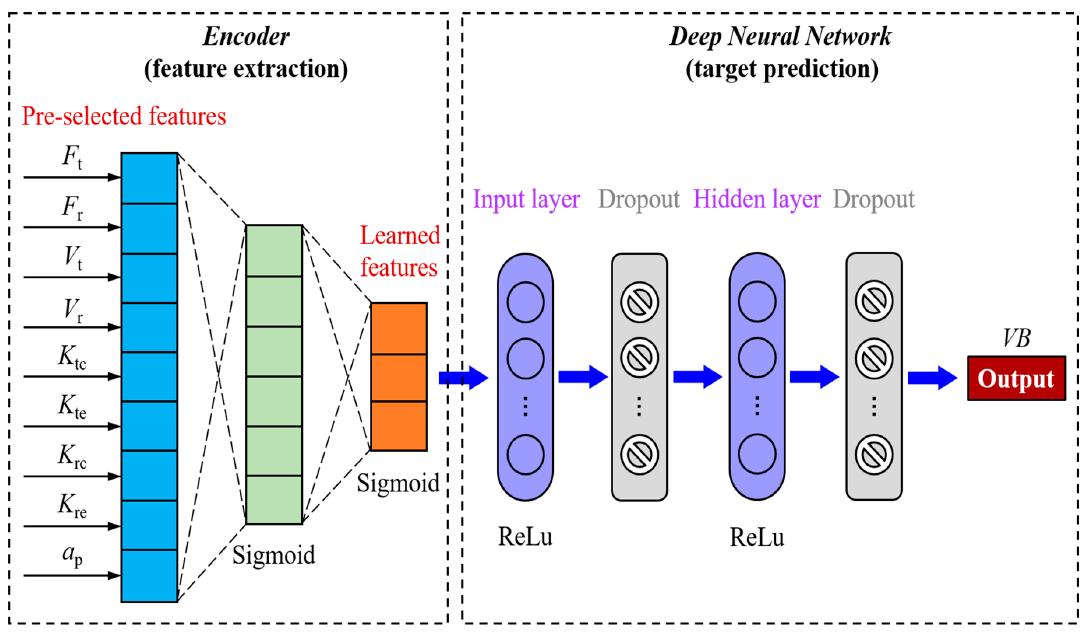
Figure 4. Architecture of deep learning network for tool wear prediction combining autoencoder and multi-layer perceptron. multi-layer perceptron. Appl. Sci. 2020 , 10 , x FOR PEER REVIEW